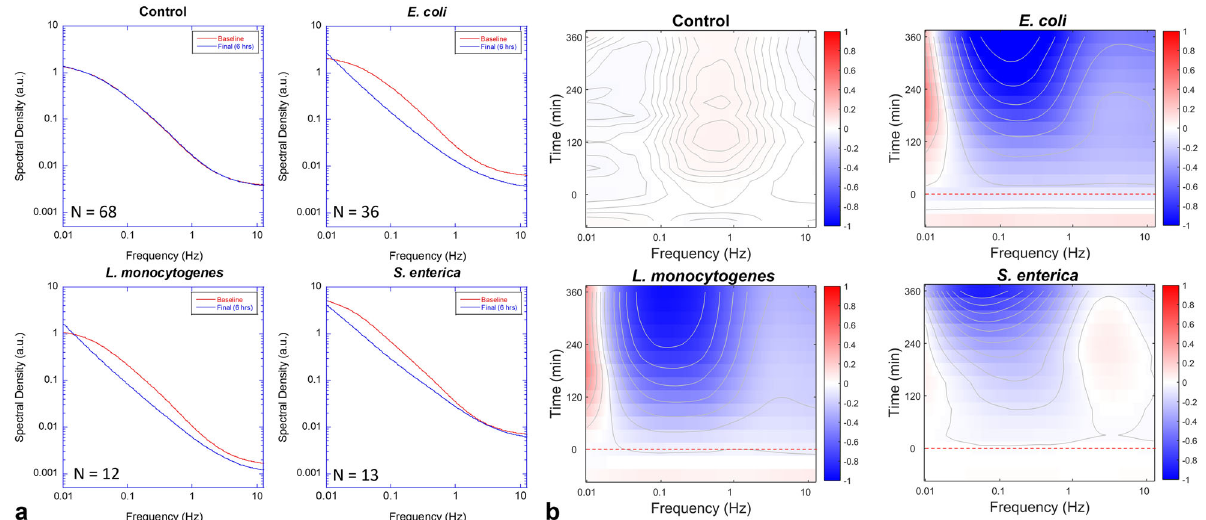
Fig. 3 Spectral responses by various bacteria. a Changes in the Doppler spectra (intensity normalized) for the four bacterial strains with initial loads of 10 6 CFU per well. Mid frequencies are inhibited in all cases with the strongest effect from E. coli . The high-frequency Nyquist fl oor (related to organelle transport) increases noticeably for S. enterica . The values for N are the number of replicate samples used in the average. The uncertainty in spectral amplitudes is ±4%. b The associated spectrograms are generated using Eq. (2). The samples are inoculated (red dashed line) after a baseline is established. The contours (10 in each graph) help show the general trends.